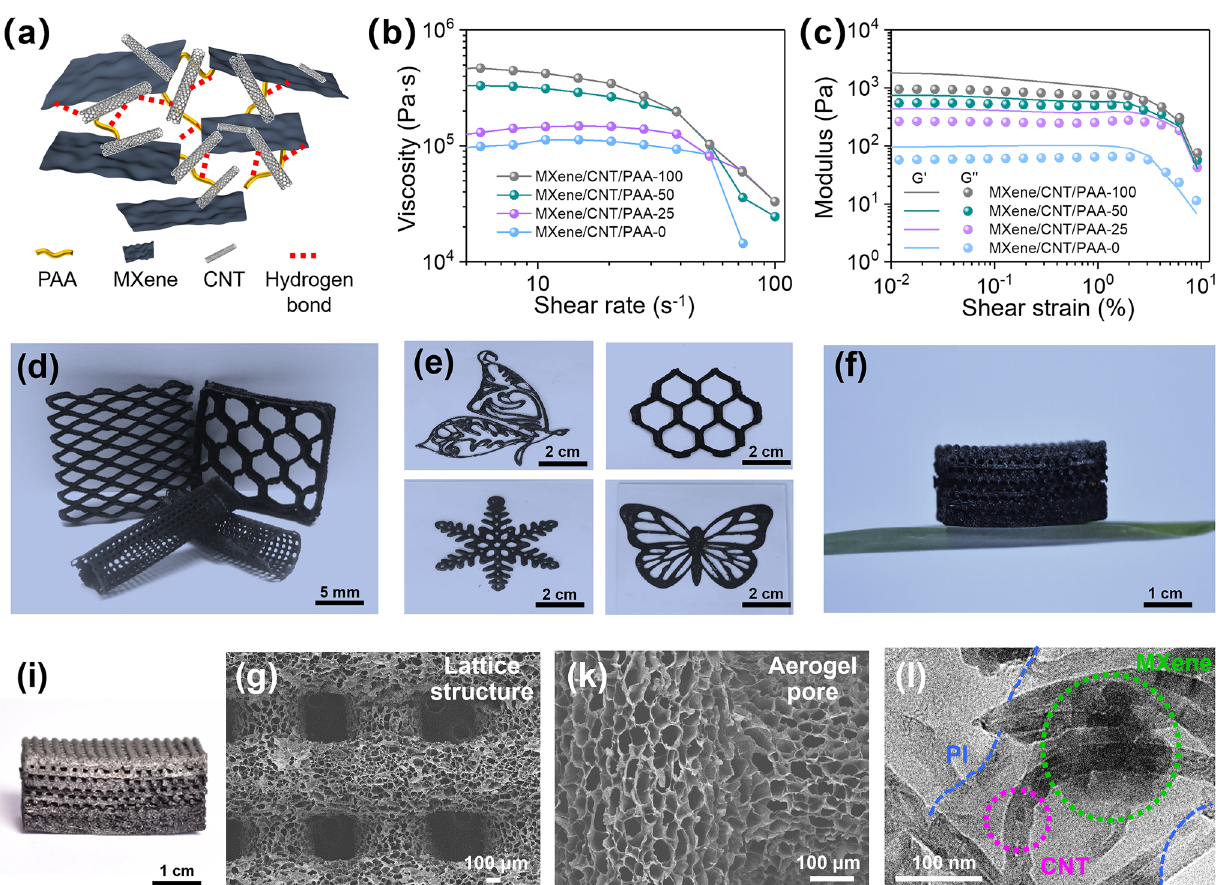
Fig. 2 Formation and morphology of GCMCP aerogel frames. ( a ) Illustration of the interaction of MXene, CNT and PAA in MXene/CNT/PAA inks. ( b ) Log–log plots of viscosity versus shear rate of MXene/CNT/PAA inks. ( c ) Log–log plots of the storage modulus (G’) and loss modulus (G’’) versus shear strain of MXene/CNT/PAA inks. ( d–e ) Optical images demonstrating the GCMCP aerogel frames with different macrostruc- tures by 3D printing. ( f ) Optical image demonstrating the lightweight of GCMCP aerogel frame. ( i ) Optical image of GCMCP aerogel frames and corresponding ( g–k ) SEM images. ( l ) TEM images of GCMCP aerogel showing the morphology of aerogel pore